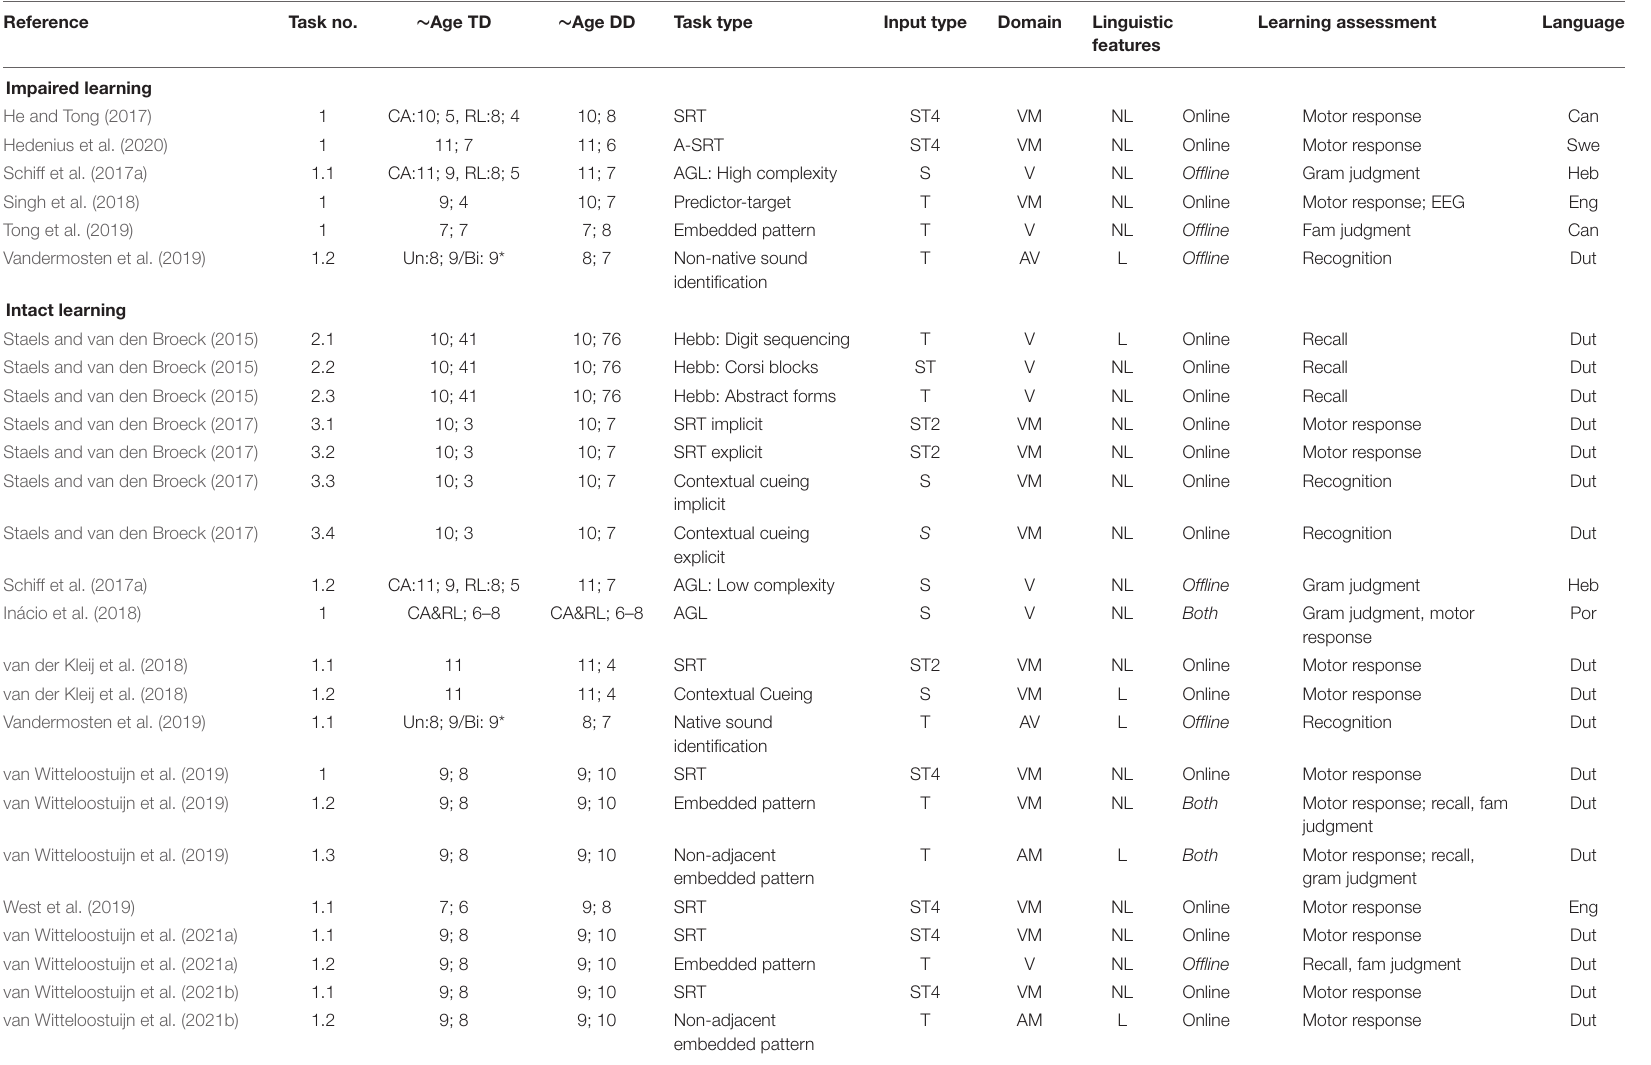
TABLE 1 | Table of studies with child participants; studies with more than one task are indicated by task number; tasks showing instances of impaired learning (top) are followed by ones showing intact learning (bottom).